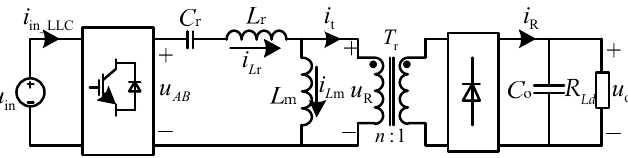
Figure 8. Circuit topology of LLC resonant converter.